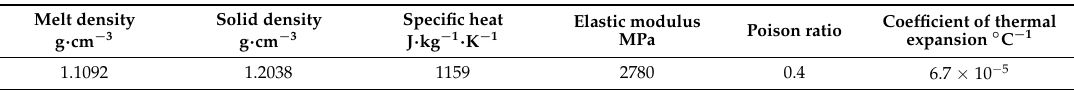
Figure 13. Geometry and finite element model of the PC/ABS phone cover. ( a ) Geometry; ( b ) Finite element model. Table 6. Basic properties of PC/ABS.